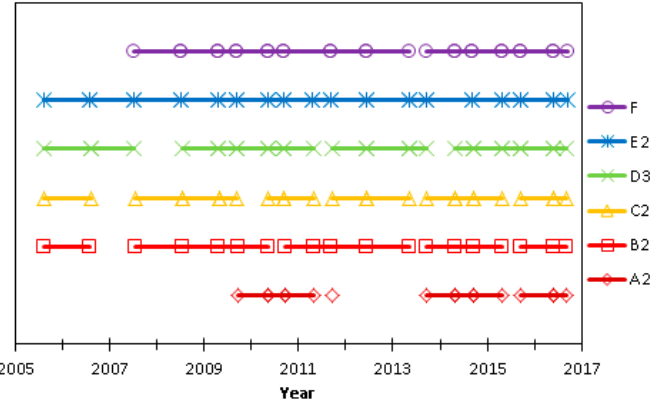
Figure 2. Available observations of 6 stakes along the central flow line of AL from 2005 to 2016. Di ff erent